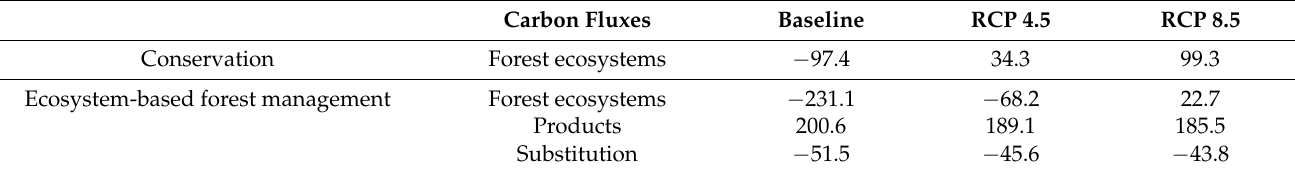
Table 2. Average annual carbon fluxes in kt CO 2 eq. year − 1 for the 2020–2120 period for conservation and ecosystem-based forest management in Maskinong é under three radiative forcing scenarios. Positive values indicate emissions to the atmosphere while negative values indicate a sequestration (removal) or emission avoidance. Carbon Fluxes Baseline RCP 4.5 RCP 8.5 Conservation Forest ecosystems − 97.4 Ecosystem-based forest